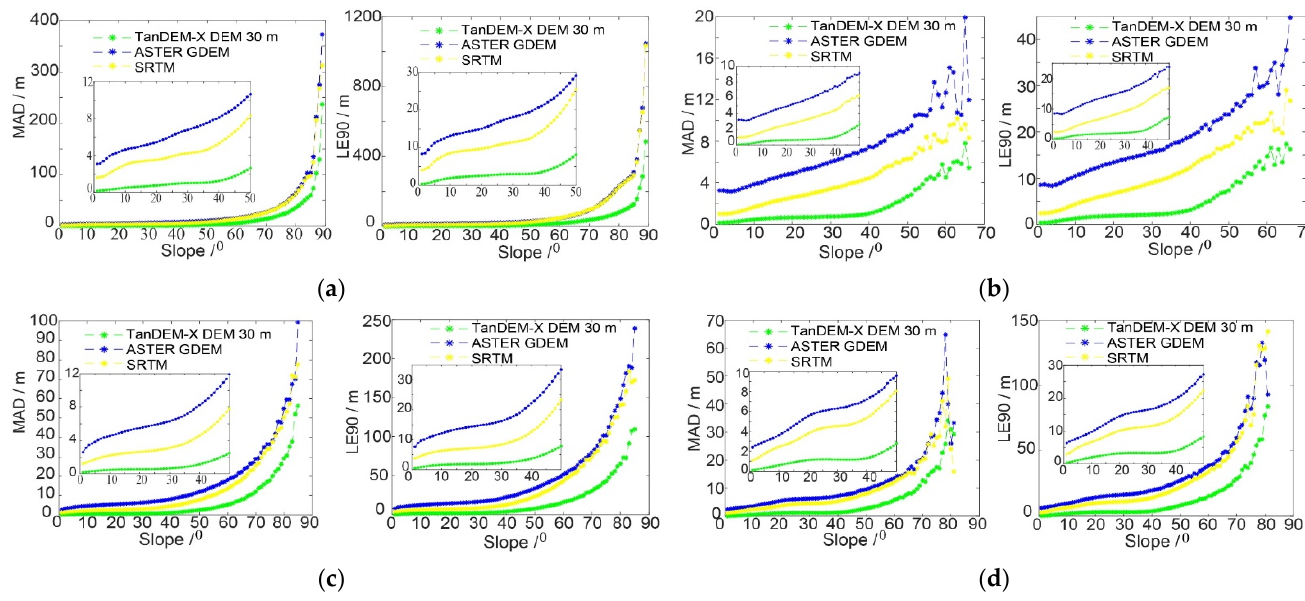
Figure 14. The relationship between quality indicators ((left) MAD and (right) LE90) and slopes in: ( a ) Sichuan; ( b ) Xinjiang A; ( c ) Xinjiang B; and ( d ) Inner Mongolia.